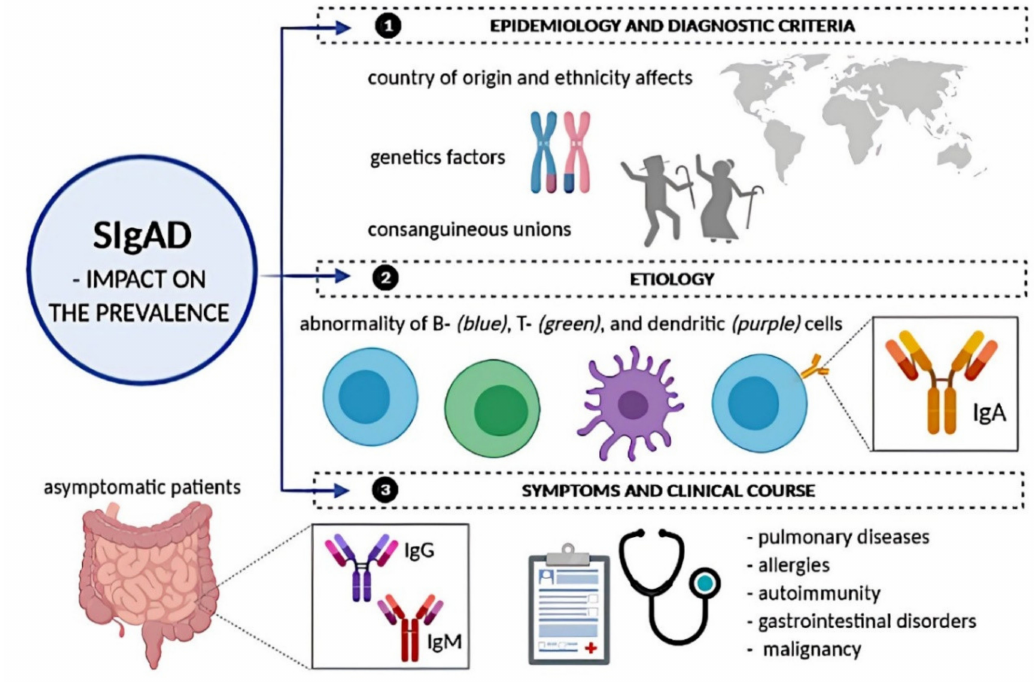
Figure 2. Factors a ff ecting the prevalence of SIgAD and its aetiology and symptoms. SIgAD, selective IgA